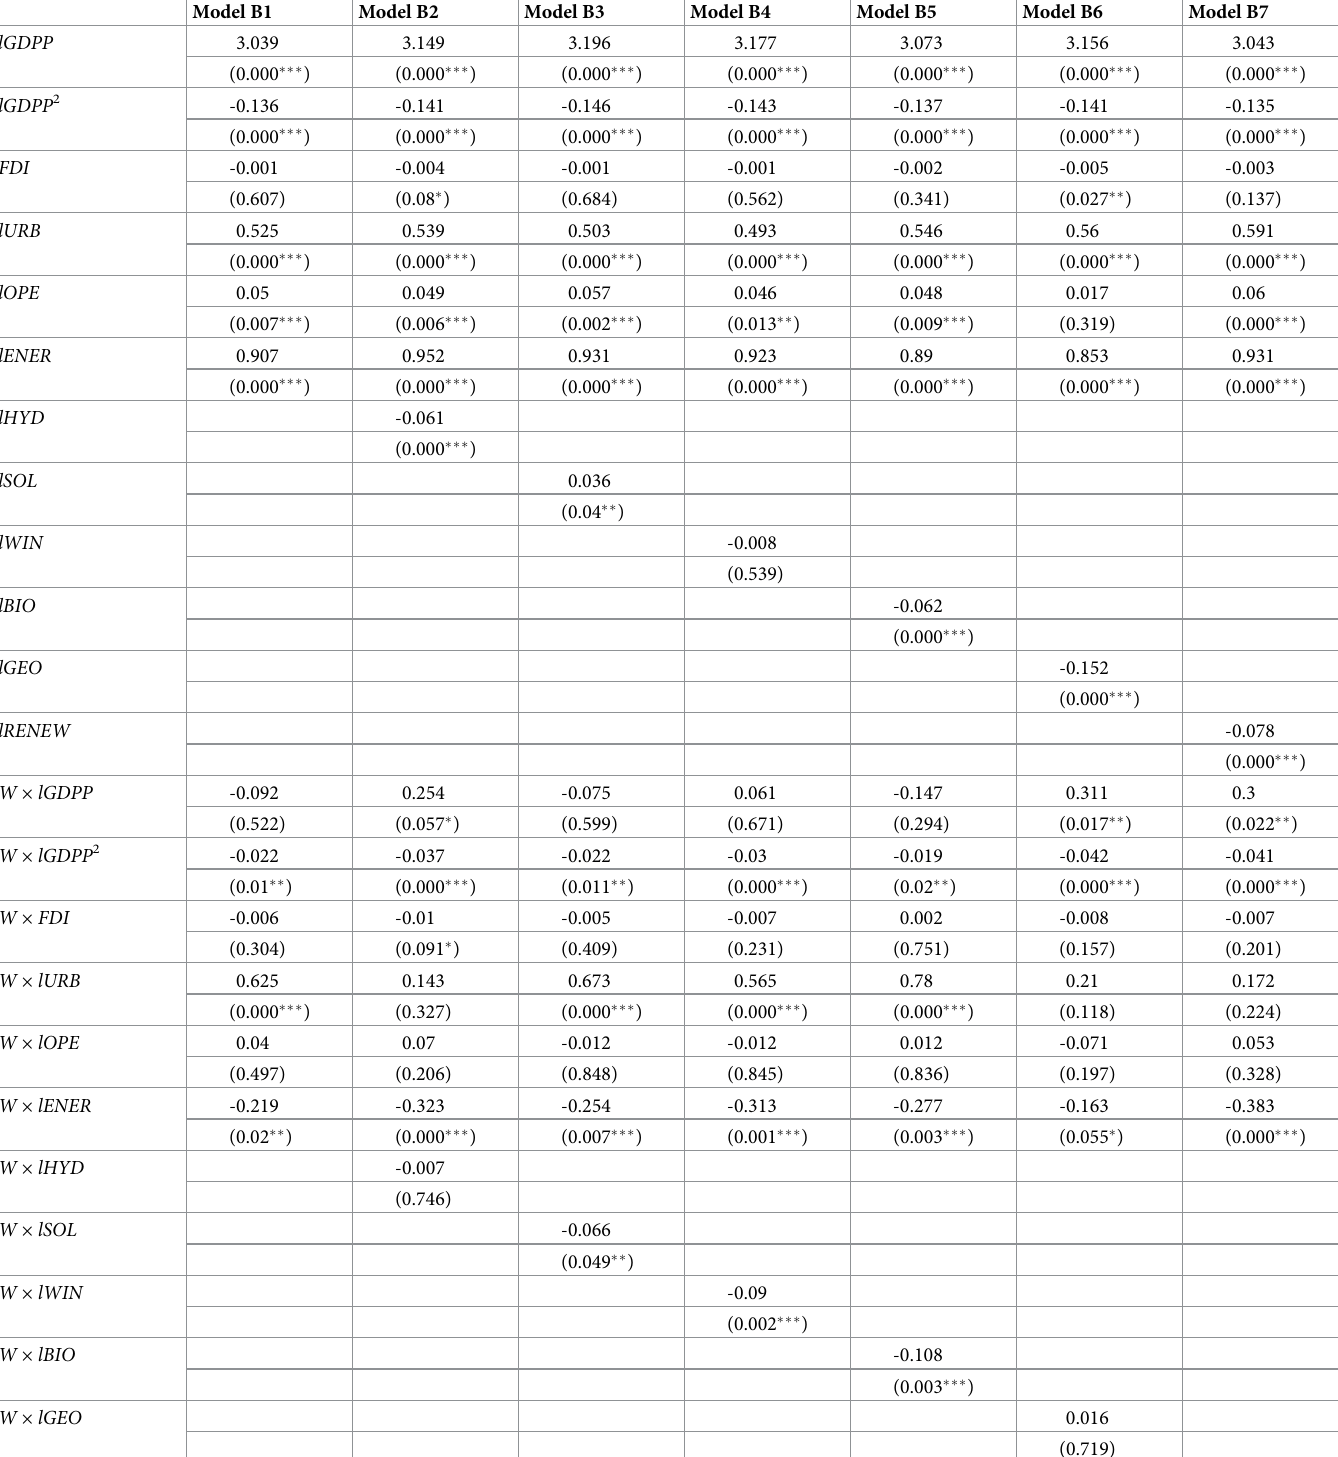
Table 6. The estimation results for the time-period fixed